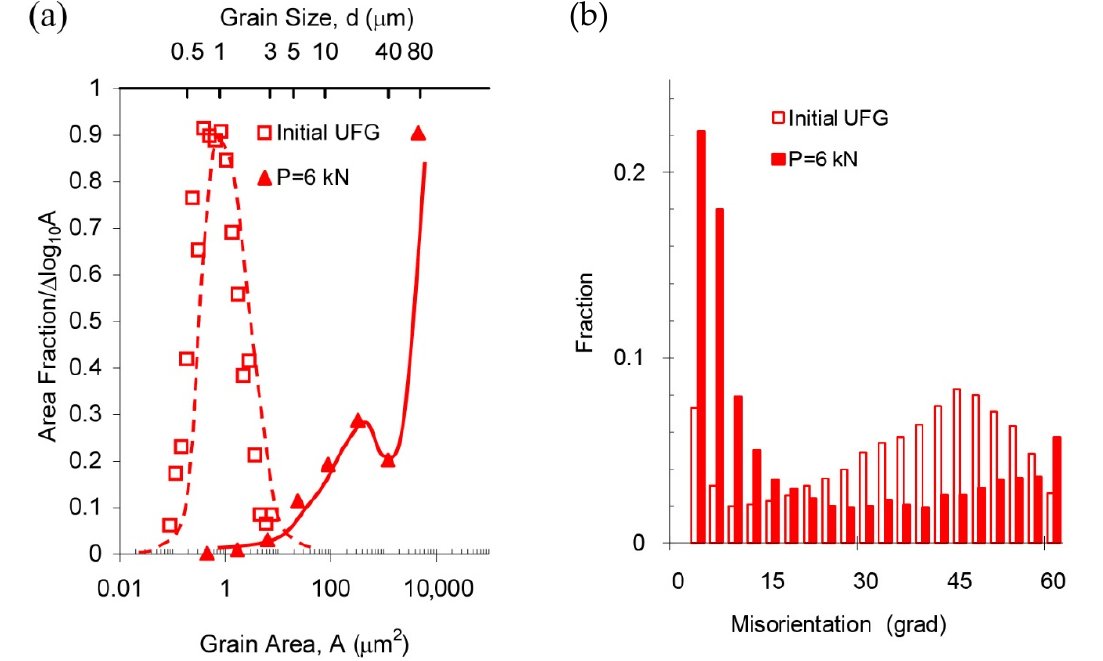
Figure 11. Typical distributions of grain sizes in the original sheet and in weld joints ( a ) and distributions of misorientation angles in weld joints processed from disks with initial UFG structure at clamping loads of 4.5 and 6 kN, respectively ( b ).